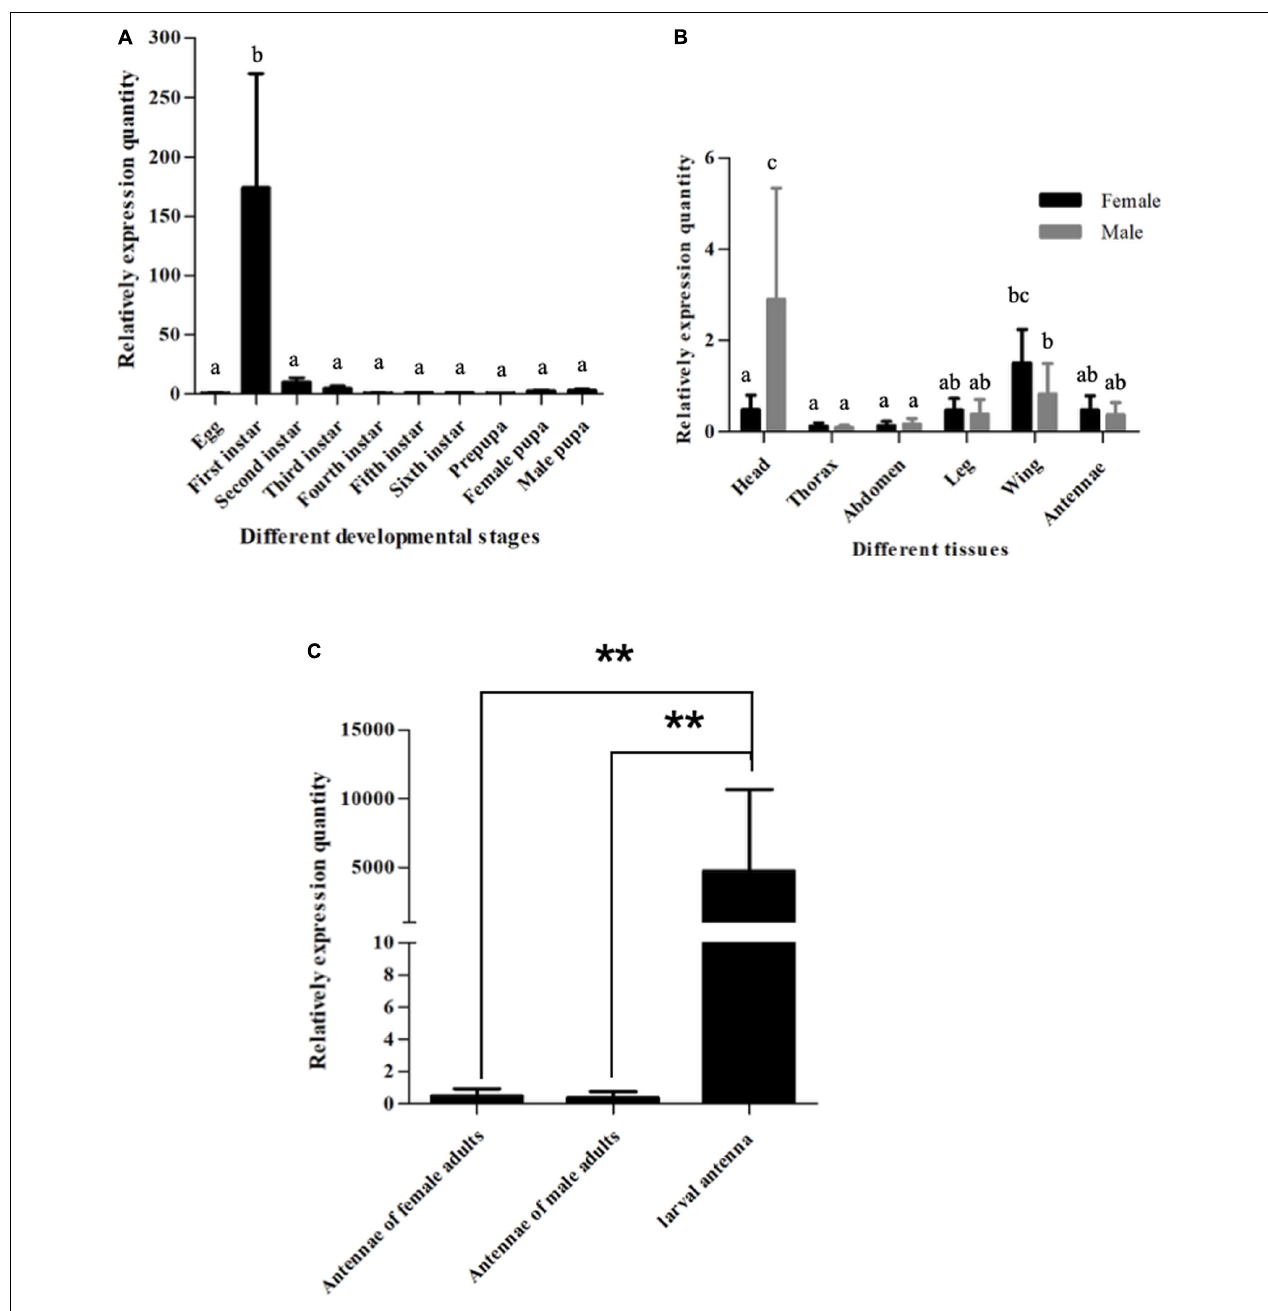
FIGURE 2 | Expression patterns of SlitOBP11 . (A) Expression patterns of SlitOBP11 at different developmental stages of S. litura . (B) Expression patterns of SlitOBP11 in different tissues of S. litura adults [head (without antenna)]. (C) Expression of SlitOBP11 in the antenna of larvae and adults. ‘**’ Means T test p < 0.01.